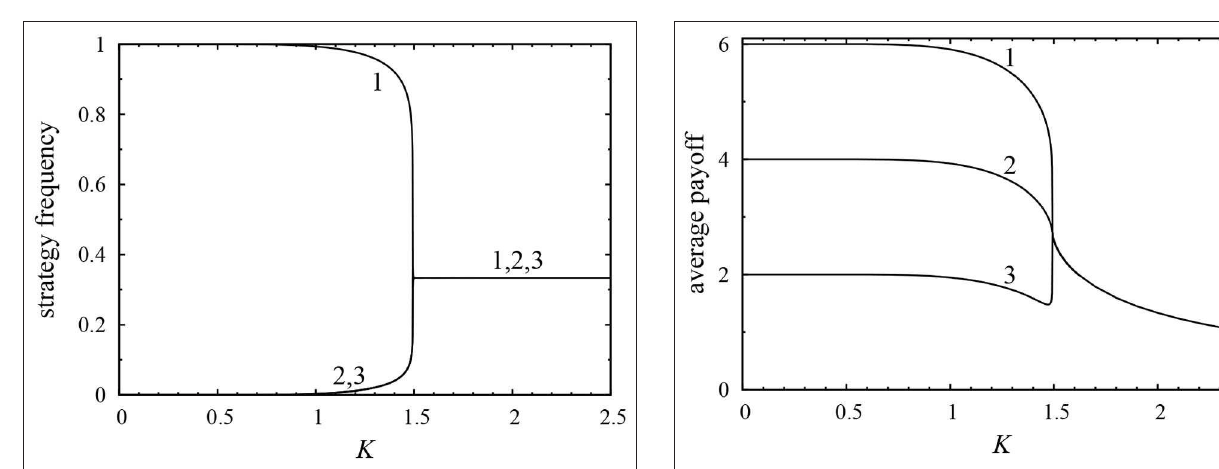
FIGURE 4 | Average payoffs as a function of K in the three possible low-noise steady states of the Potts model defined by Equation (24) with additional cross-dependent components ( γ 1 curves refer to the majority strategy.